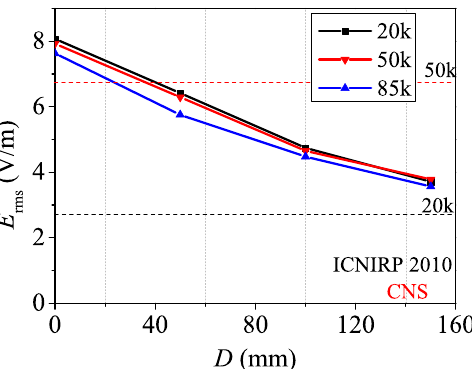
Figure 11. Curves of internal E -field strength of the human body versus transfer distance at various